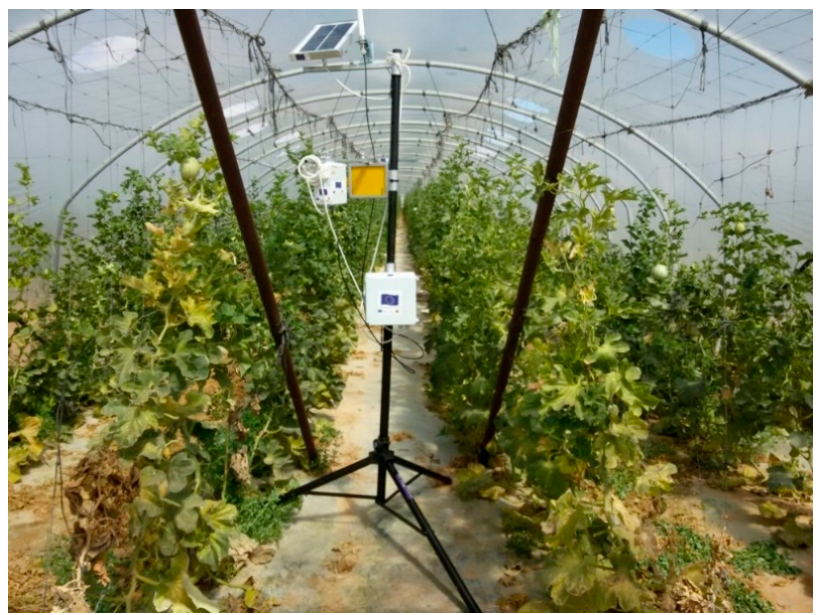
Figure 6. Image of a RETIC-Real Time Insect Counting Trap, wireless, monitoring system in the gate of a melon growing greenhouse in Ein Yahav, Arava Valley, during the spring of 2015.